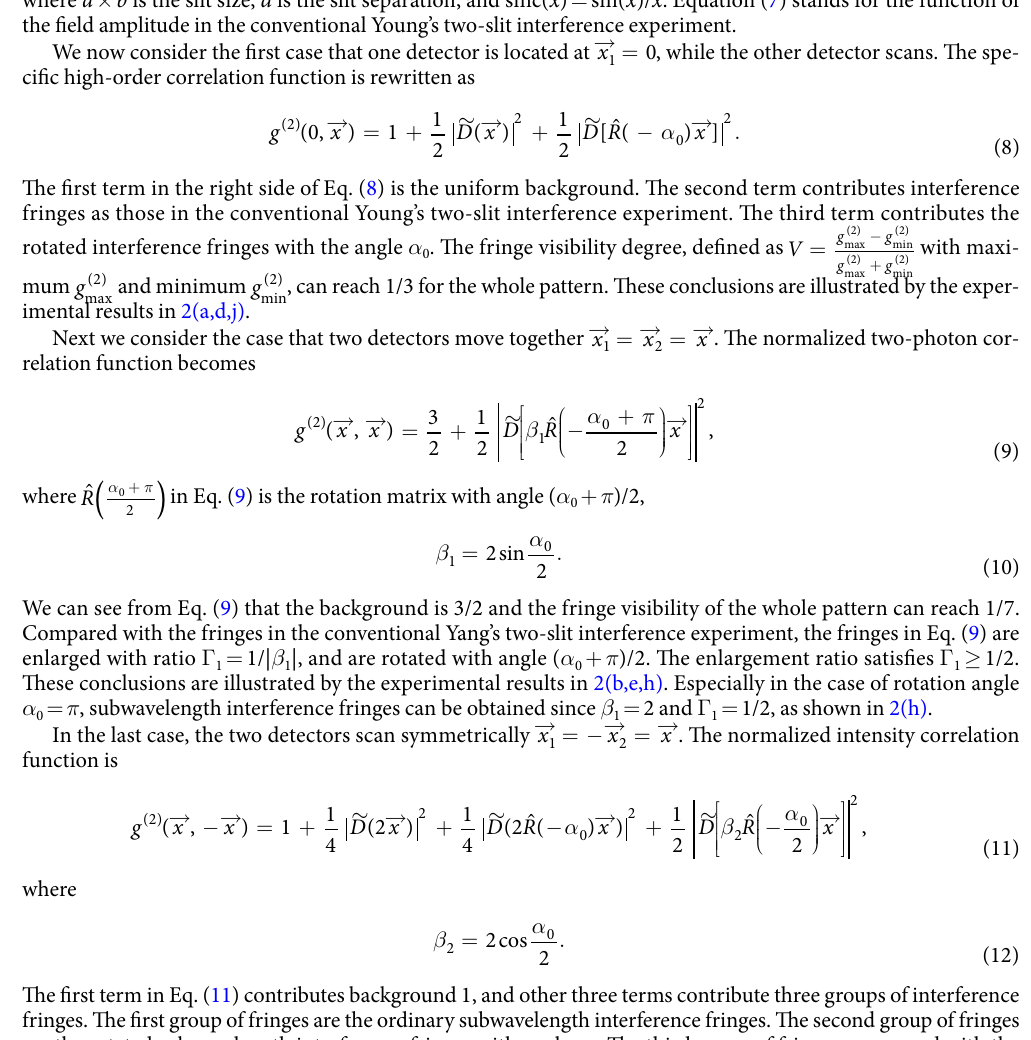
, and are plotted with solid and dashed lines,